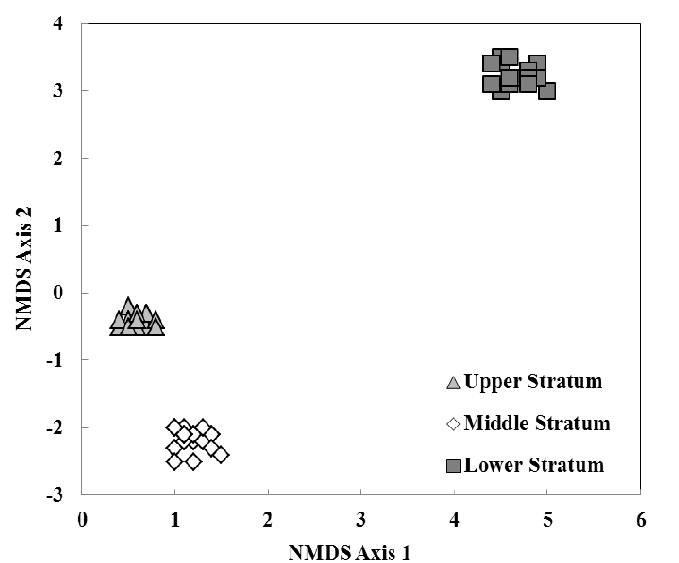
Figure 3. Non-metric multidimensional scaling (NMDS) ordination of six eastern hemlock trees sampled three times based on specimen abundance and Bray-Curtis similarities. Each individual point (n = 18) represents a stratum within a host tree sampled at one sampling time. Distance between points represents the degree of dissimilarity in species composition, i.e. , the further the distance, the more dissimilar the species